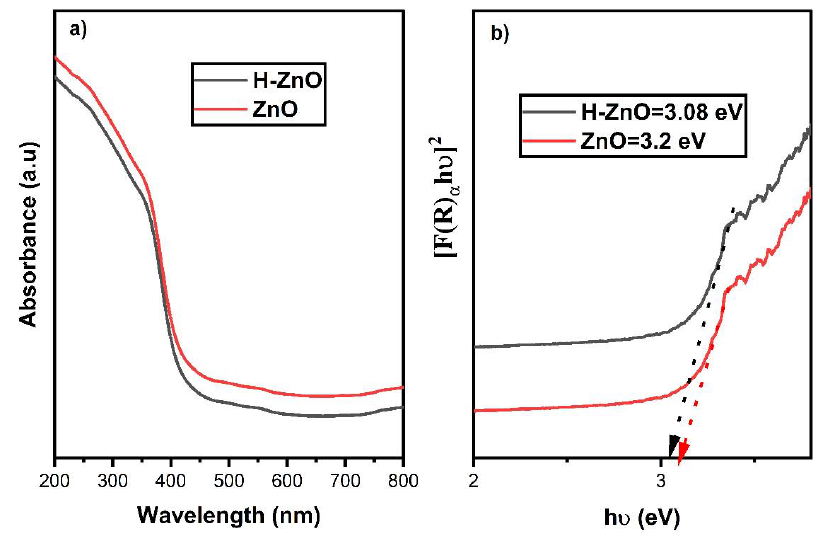
Figure 3. ( a ) UV–Vis DRS spectra and ( b ) estimated band gaps of ZnO and H-ZnO.